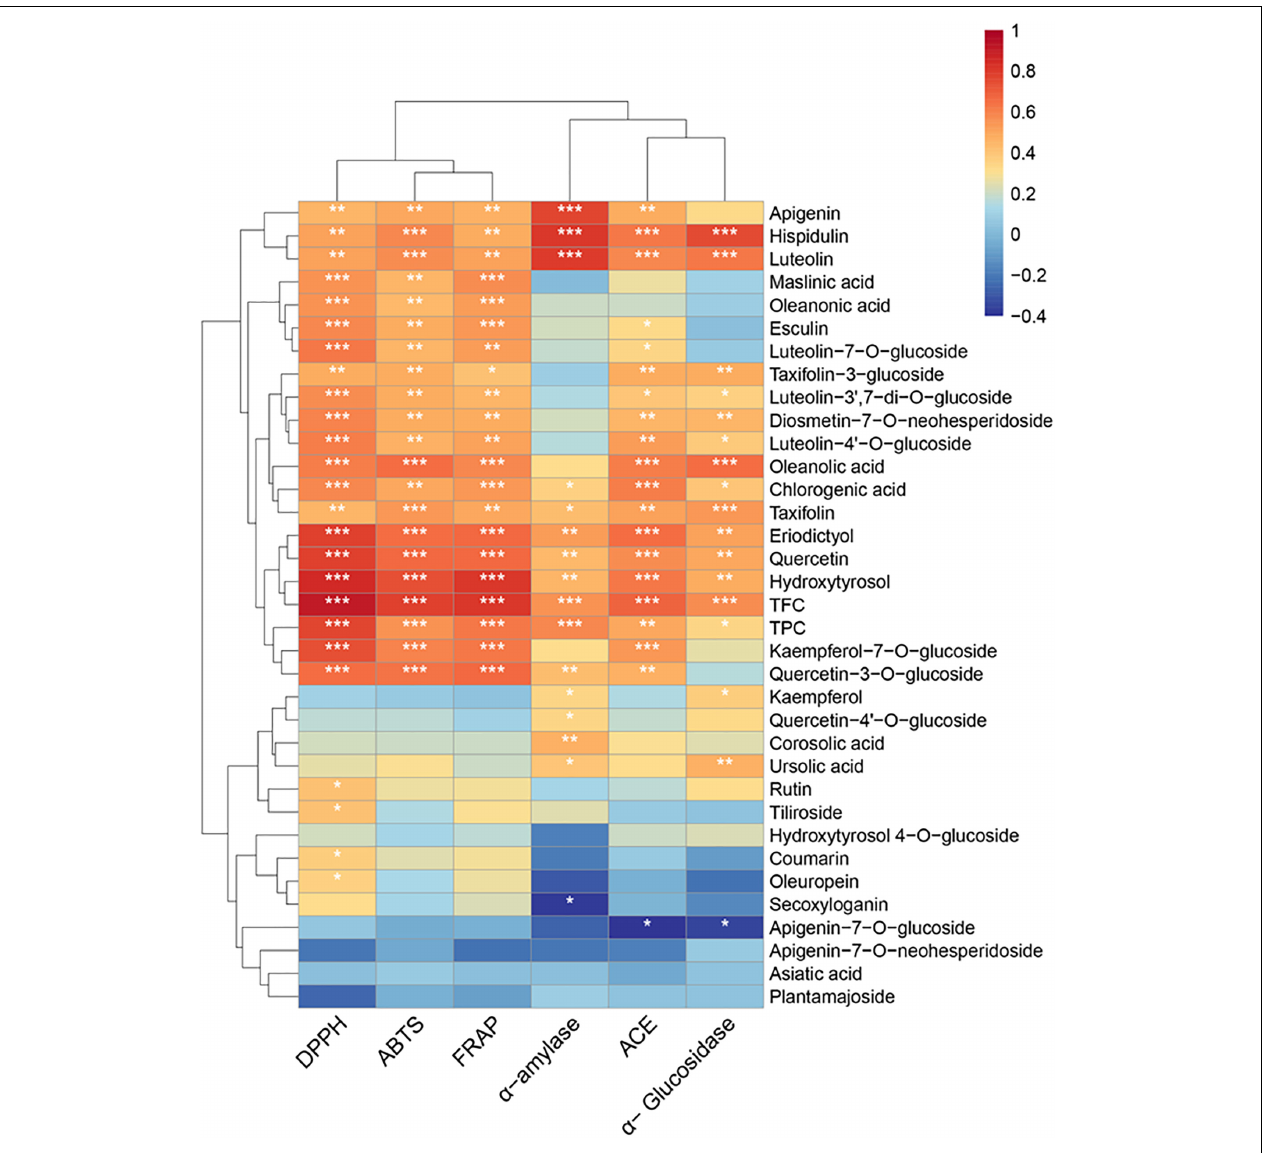
FIGURE 3 | Heat map of Spearman’s correlation between chemical constituents and the bioactivities (DPPH; ABTS; FRAP; α -amylase, α -glucosidase, and ACE inhibition) of the olive leaf extracts. Significance levels are indicated as follows: * P < 0.05; ** P < 0.01; *** P <